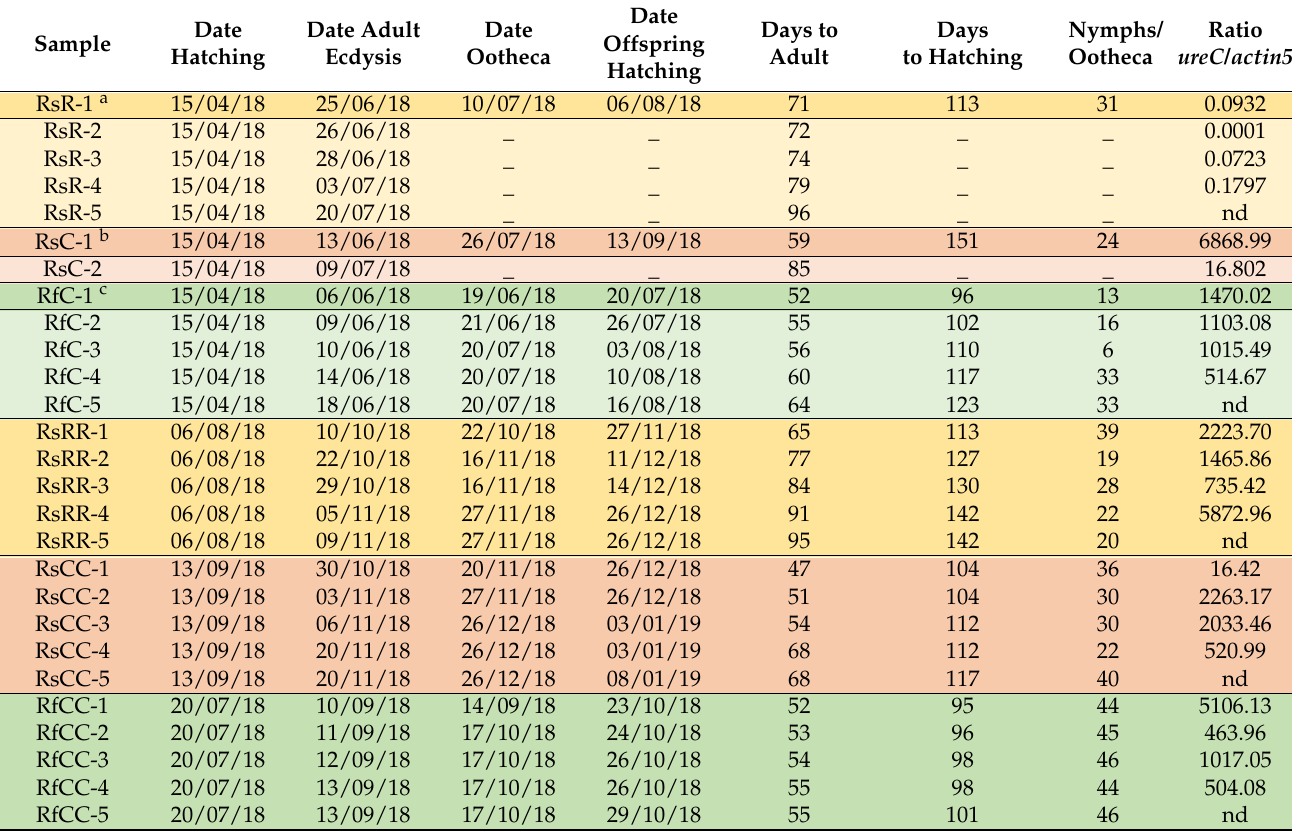
Table 1. Female cockroaches of G2 and G3 analysed in this study. Columns indicate the dates (day/month/year) corre- sponding to relevant points in the developmental process (hatching, adult ecdysis, ootheca appearance, offspring hatching), number of days from hatching to reach adult stage and to next-generation hatching, reproductive capability (nymphs per ootheca), and endosymbiont population density (ratio ureC/actin5C